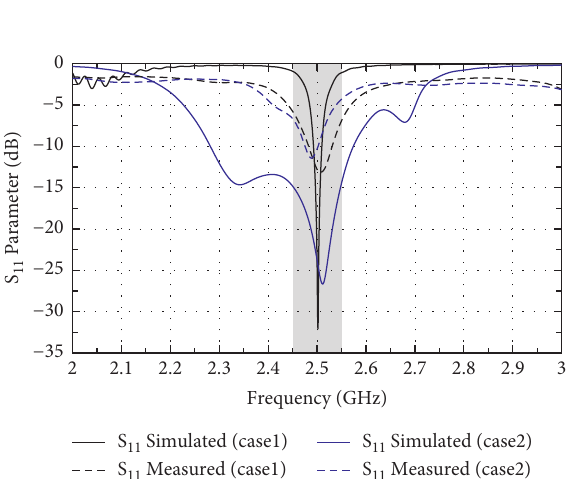
Figure 13: Simulated and measured S